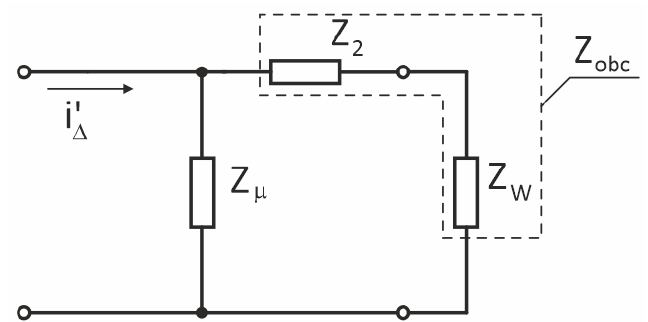
Figure 3. Simplified equivalent diagram of the summation transformer for determining the impact of load matching.